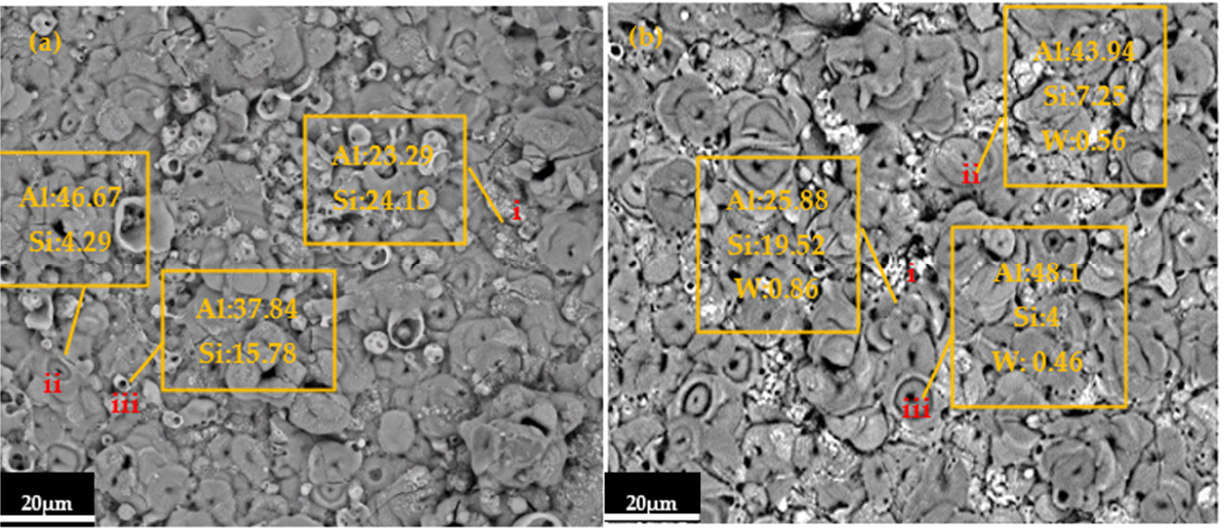
Figure 6. The EDS analysis of different surface morphologies of the produced coatings: ( a ) S1 and ( b ) S1W .